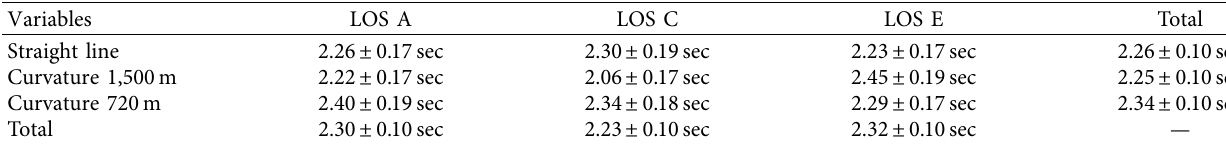
Table 7: Takeover times by LOS and